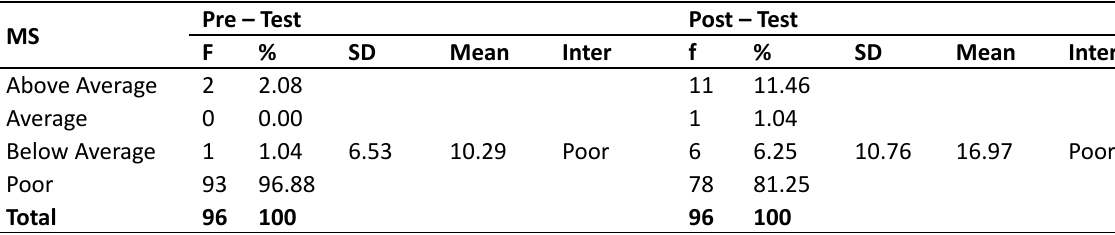
Table 5. Muscular Strength